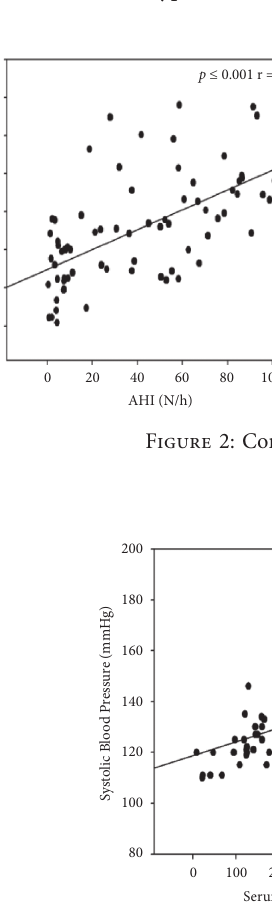
Figure 3: Correlation between blood pressure (SBP and DBP) and serum irisin level.